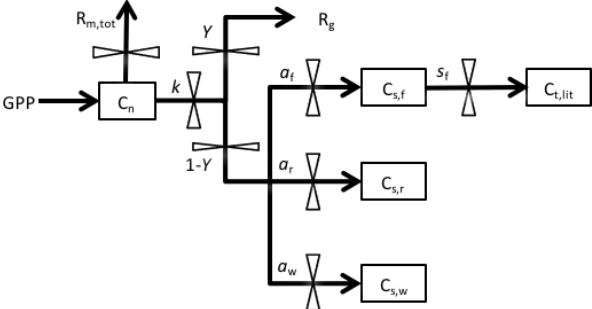
Figure 1. Structure of the carbon balance model. Pools are shown as boxes: C n , nonstructural storage C; C s , f , structural C in foliage; C s , r , structural C in roots; C s , w , structural C in wood. Fluxes,